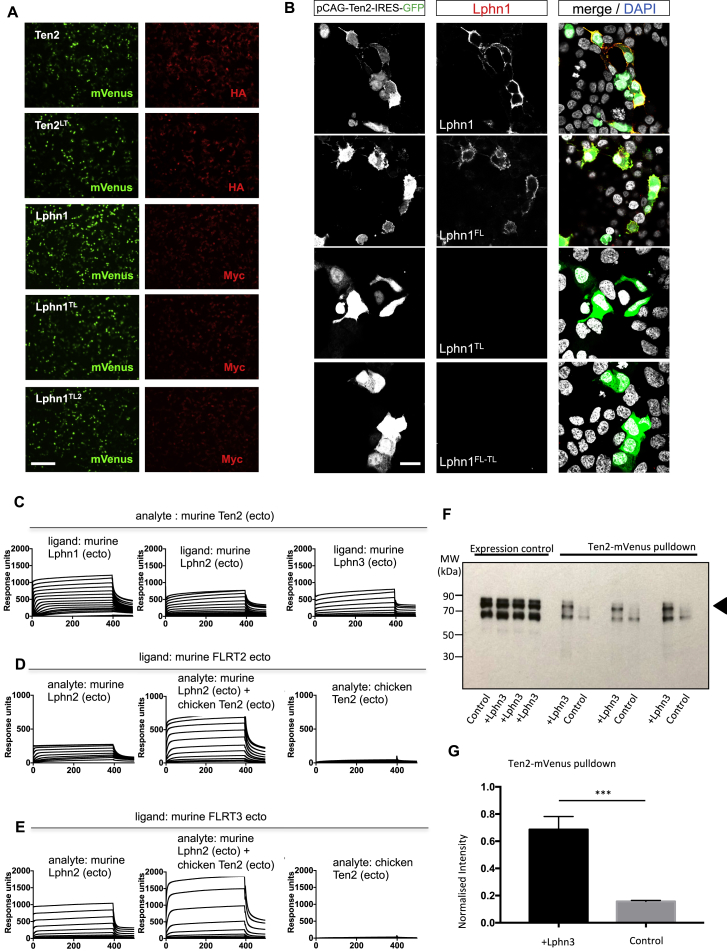
Teneurin, Latrophilin, and FLRT Interaction Studies, Related to Figure 2(A) Teneurin and Latrophilin constructs were expressed in HEK293 cells with an intracellular mVenus and extracellular HA or Myc tag, respectively. We visualized cell surface expression with anti-HA or anti-Myc staining of fixed non-permeabilised cells. The staining shows that the constructs used in this study were all successfully expressed at the cell surface. Scale bar = 150 μm. (B) We tested the binding of Lphn1 (Lec-Olf) wild-type, single or double mutant proteins, clustered with anti-His and anti-mouse Alexa-594 (red), to HEK293 cells expressing Ten2 (green). Lphn1 and the non-FLRT binding (FL) mutant bind to Ten2. Non-Teneurin binding (TL) mutants do not bind. (C-E) SPR response curves are shown. The response units (y axis) are plotted against the time in seconds (x axis). (C) We immobilised 700 response units of murine Lphn1 (ecto), Lphn2 (ecto), or Lphn3 (ecto) on separate flow cells and injected a concentration series of mouse Teneurin 2 protein (highest concentration = 3.65 μM). (D, E) We immobilised 440, 300 and 1200 response units of FLRT2 (ecto) or FLRT3 (ecto). We injected Teneurin and Lphn proteins using the same concentration series in each experiment (highest concentration = 660 nM). (F) mVenus-tagged Ten2 was pulled down from HEK293T-cells co-transfected with FLAG-FLRT2, after incubating with either Lphn3-transfected cells or untransfected control cells. Anti-FLAG western blots show that FLRT2 is preferentially pulled down in the presence of Lphn3-expressing cells, compared to untransfected controls. Three representative repeats are shown. FLRT is highlighted by the arrow head. (G) Quantification of results shown in F. Results averaged from 6 experiments. Statistical significance was determined with a two-tailed unpaired t test where ∗∗∗p = 0.0003. Error bars show the s.e.m.